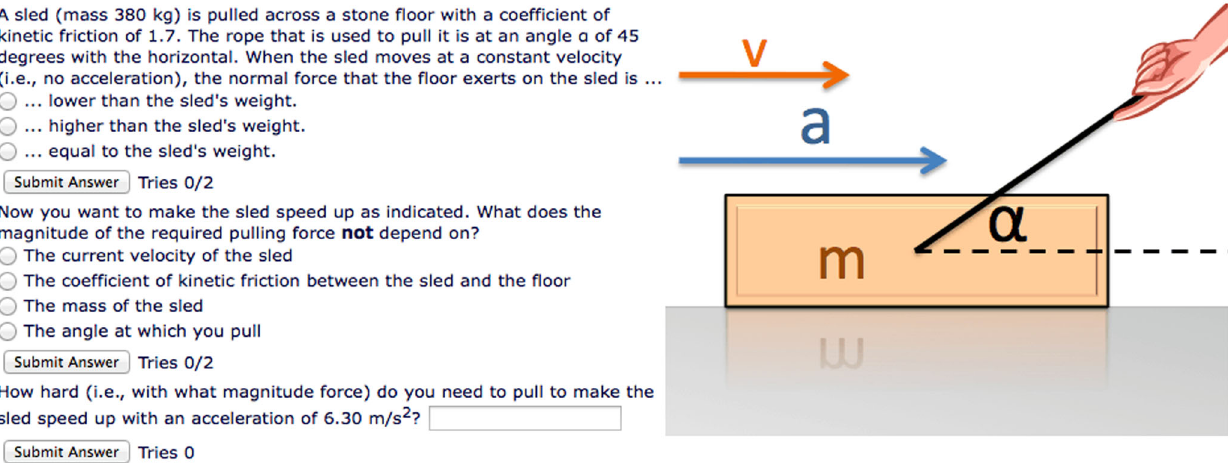
FIG. 1. An example of a homework problem from the course under investigation. Different students have different masses and angles, as well as different multiple-choice options in different order. In this course, students have 99 tries on the free-form part of the problem. Students can use any physical unit with the right